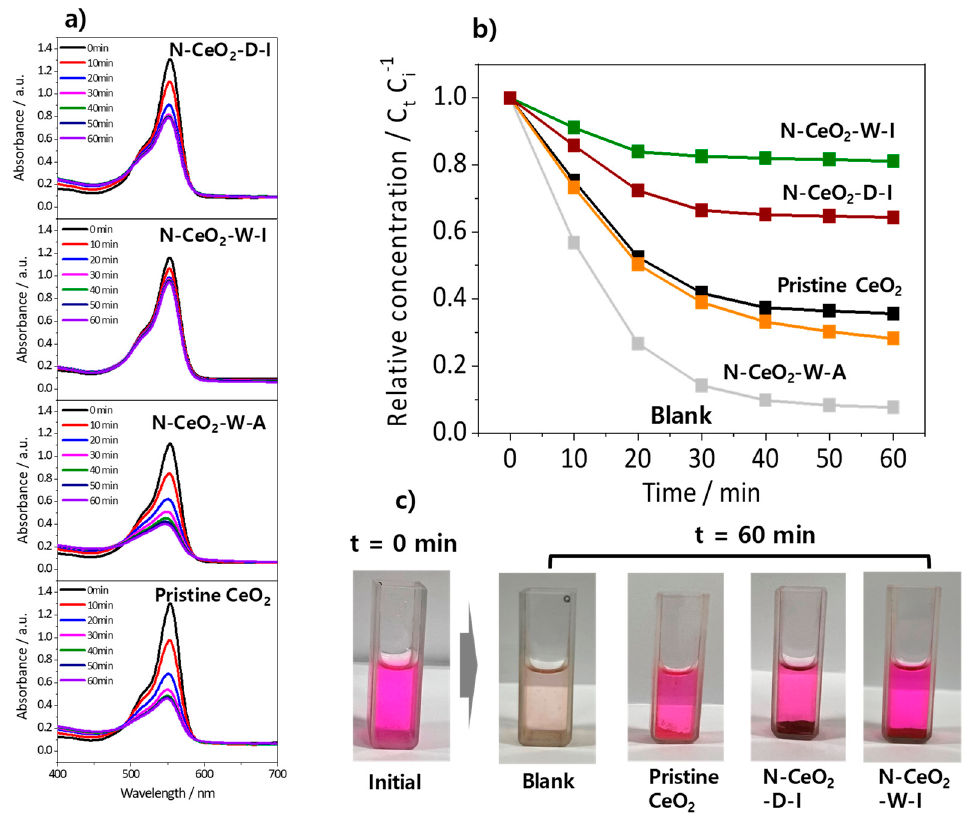
Figure 8. ( a ) UV–Vis spectra of the Fenton’s solutions with RhB and the radical scavengers added. ( b ) The relative RhB concentration in the solution over time after adding the radical scavenger in the solution. ( c ) Photograph of the solution before and after the radical scavenging test.